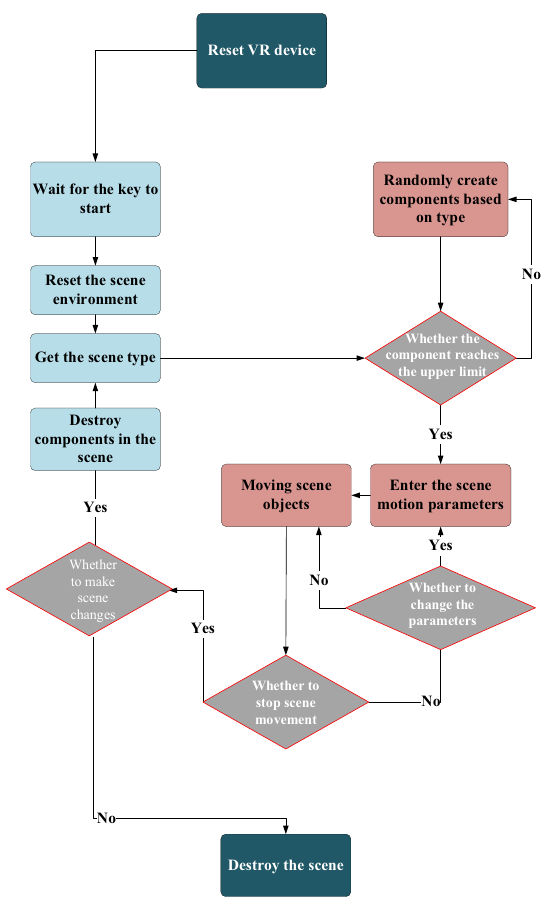
Fig. 2 Immersive VR dizziness